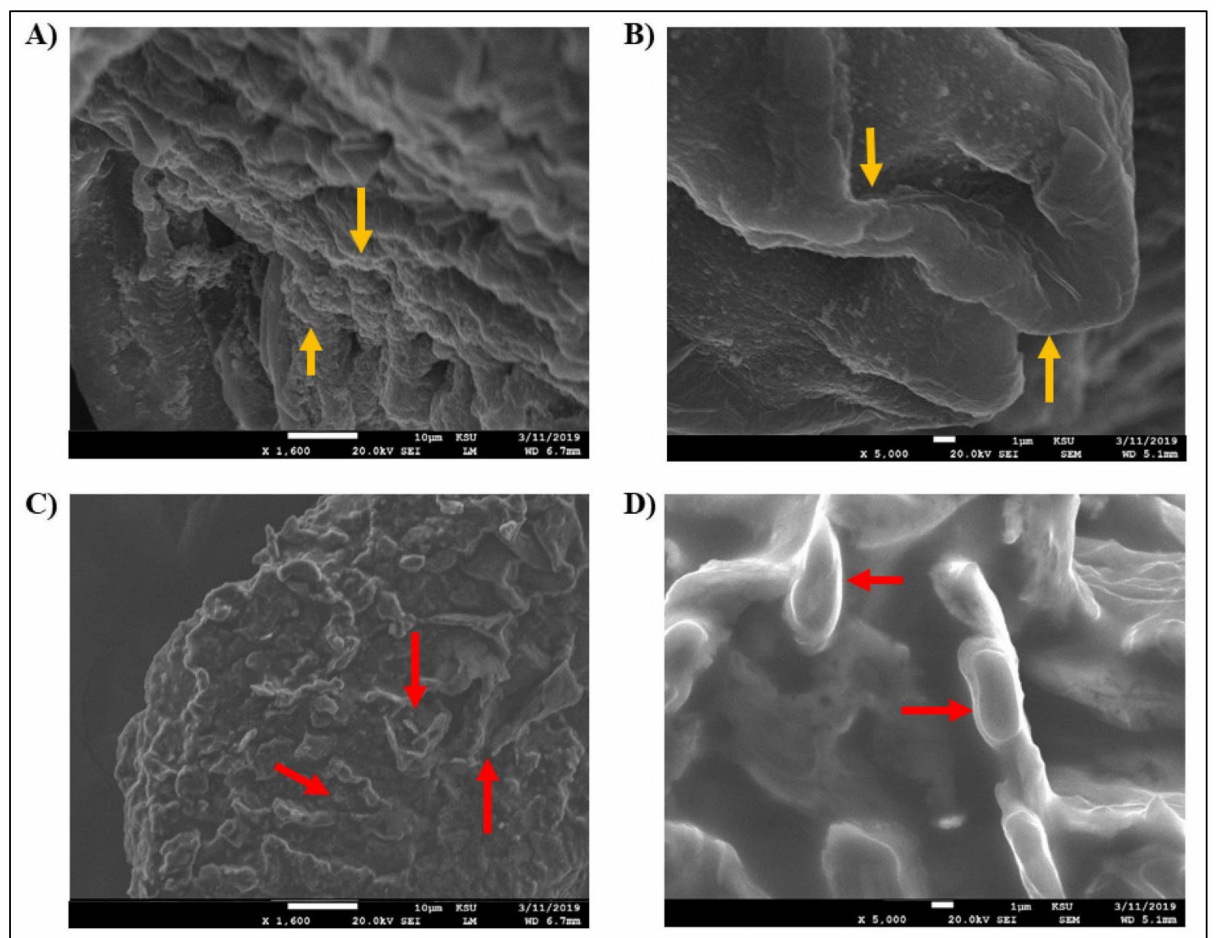
Figure 3. SEM imaging results of D. spicifera . The fungal growth was visualized and captured with JEOL JEM-2100 microscope. ( A ) At 1600 × and ( B ) 5000 × , images show the untreated samples as a control, with the yellow arrows indicating the lean and homogeneous fungal structures with wrinkled and intact structure. ( C ) At 1600 × and ( D ) 5000 × , images show the fungus treated with 1% crude oil, the red arrows show the fungus fragments as they were cut into small and twisted pieces, where in ( D ) the arrows show the inconspicuous conidia spore morphology.